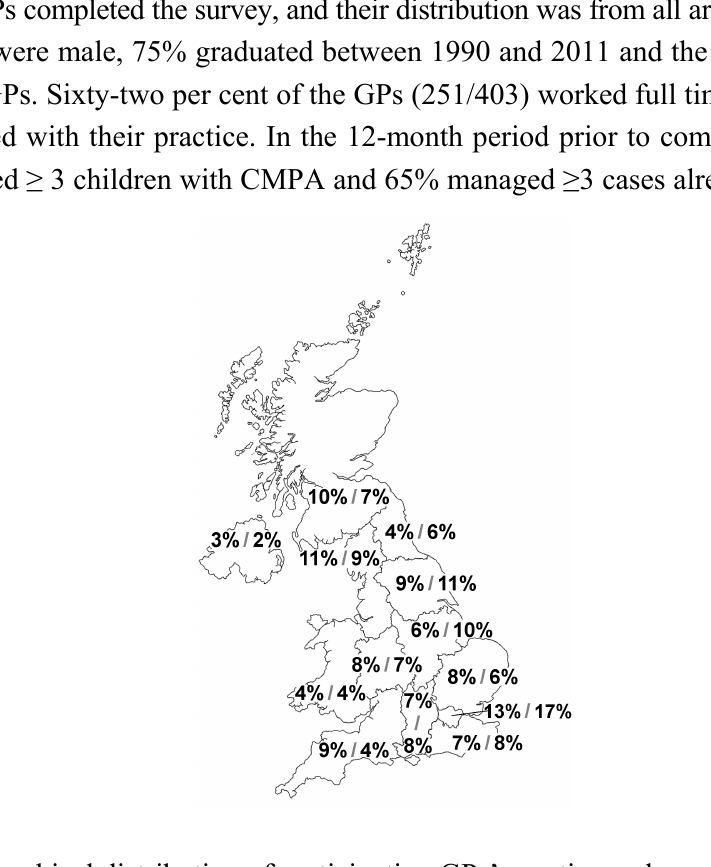
Figure 1. Geographical distribution of participating GPs’ practice and parents (%GP/%Parent). Table 1. Summary of GPs’